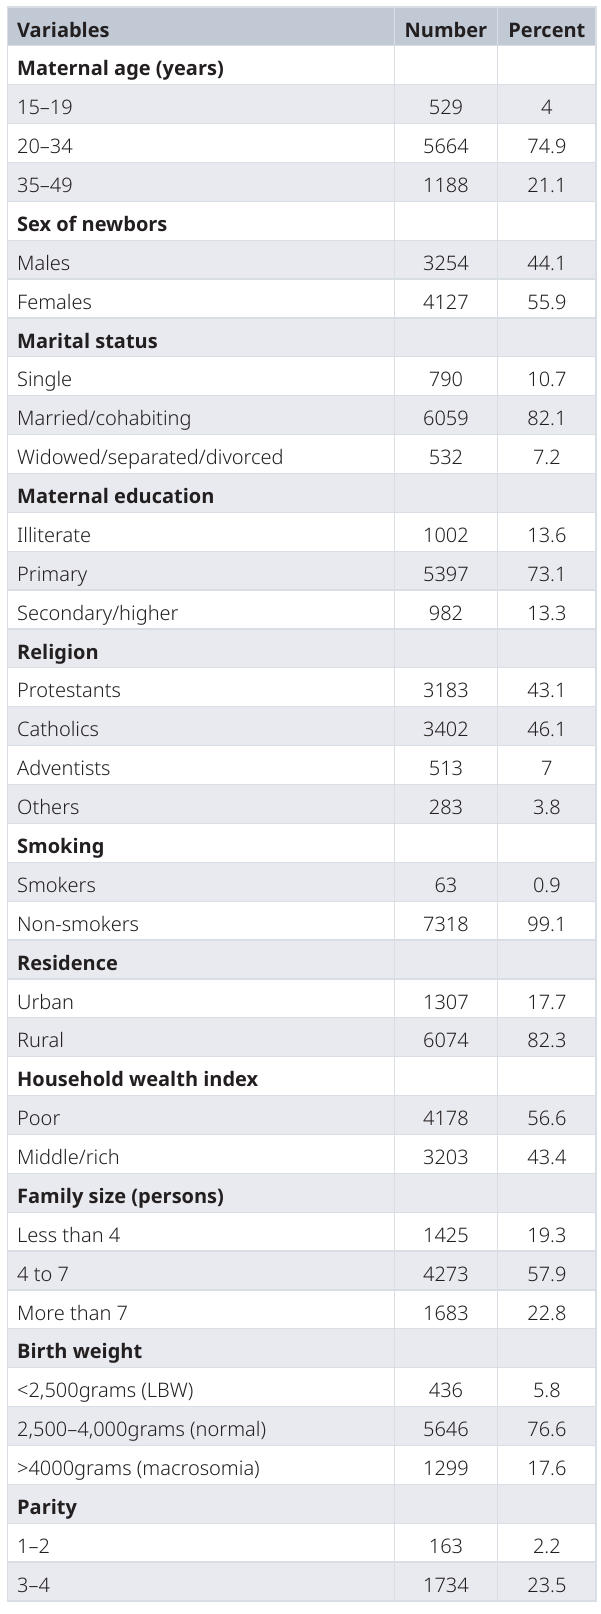
Table 1. Descriptive analysis for socio-demographic, nutritional, maternal and economic factors